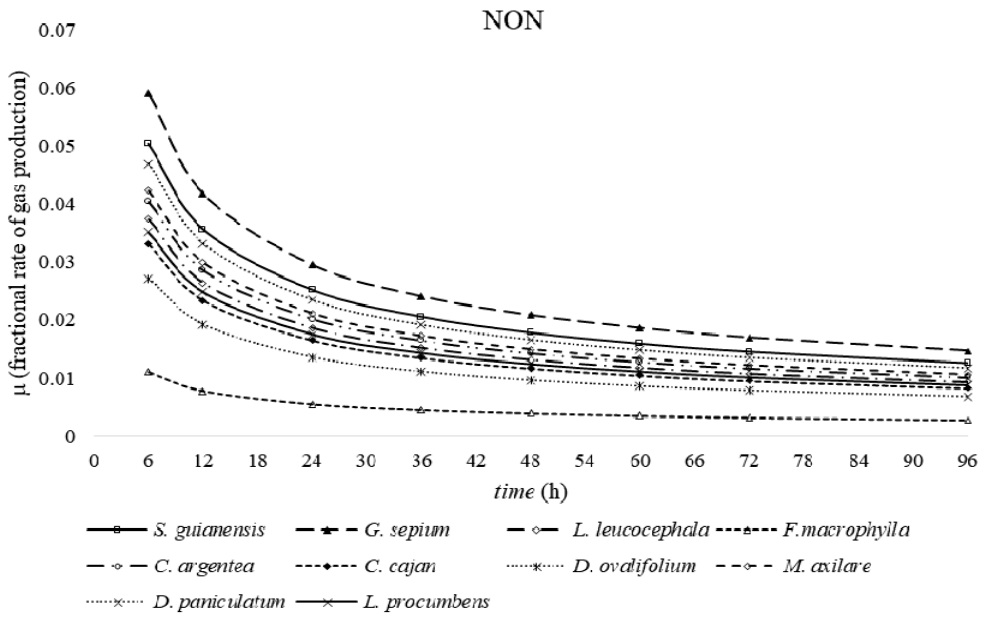
Figure 4. Gas production curves of legumes forages incubated at the end of 96 h.